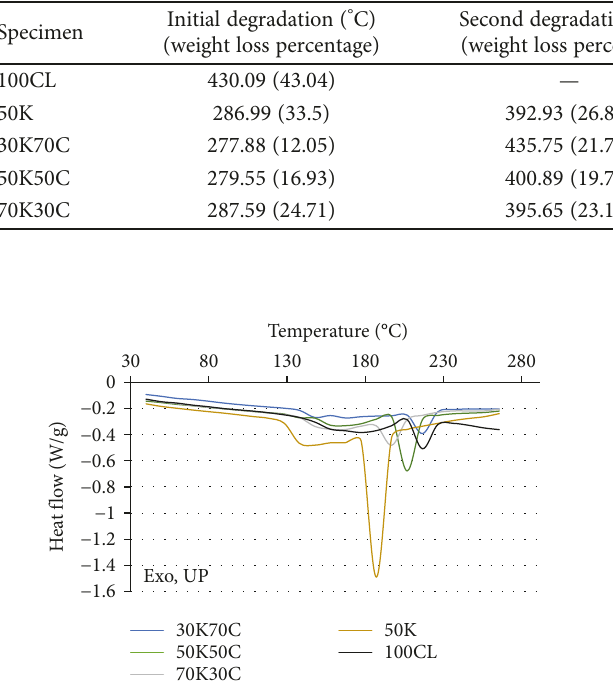
Figure 4: DSC of the hybrid composites. Table 3: Melting point and decomposition peak temperature.